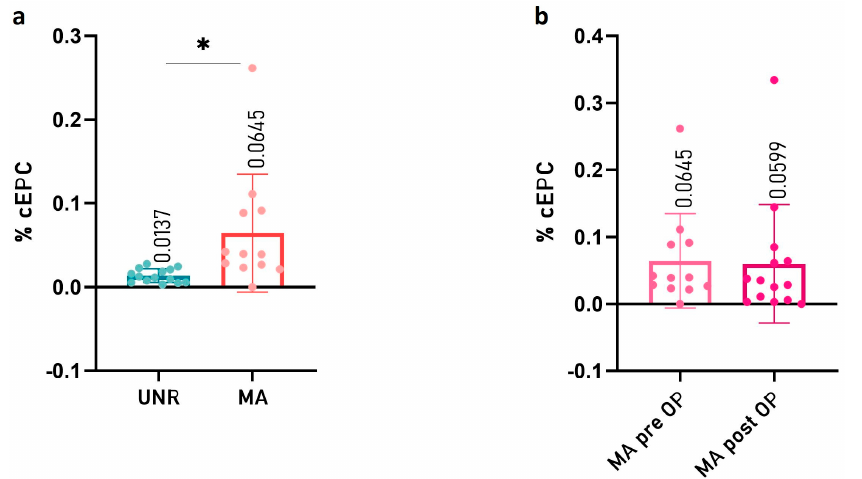
Figure 1. Flow cytometer analysis of circulating EPCs. The EPC counts in the peripheral blood were determined with flow cytometry on whole blood samples: ( a ) CD45 + events on Gate1 region using PE-Vio770-labeled antibodies against CD45; ( b ) proportion of CD34 + cells on CD45 + -gated events as analyzed in the Gate2 region using FITC-labeled antibodies against CD34; ( c ) Gate3 region-selected CD45 dim cells; ( d ) triple-positive cells were identified by the dual expression of CD34 and CD133 (PE-labeled antibodies) within the CD45 dim -gated population. Because EPCs are rare in normal peripheral blood, at least 500 CD34 + events ( b ) per sample were acquired.